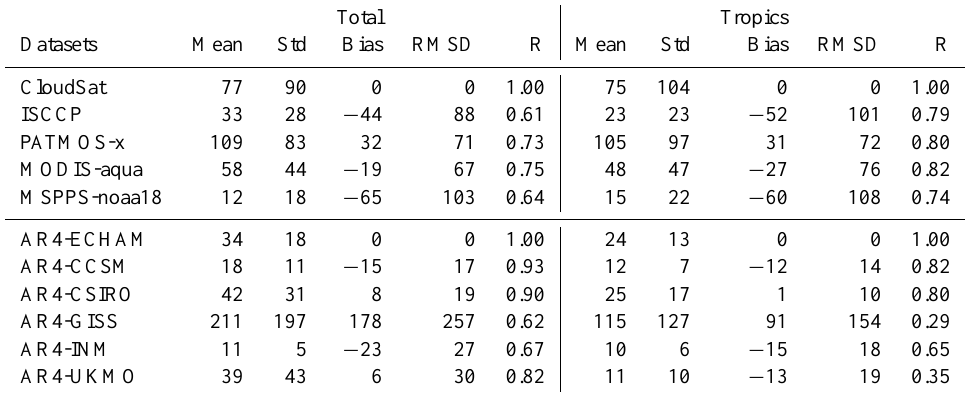
Table 4. IWP Statistics using monthly means [g / m 2 ] for selected satellite datasets and climate models. Statistics are provided for the